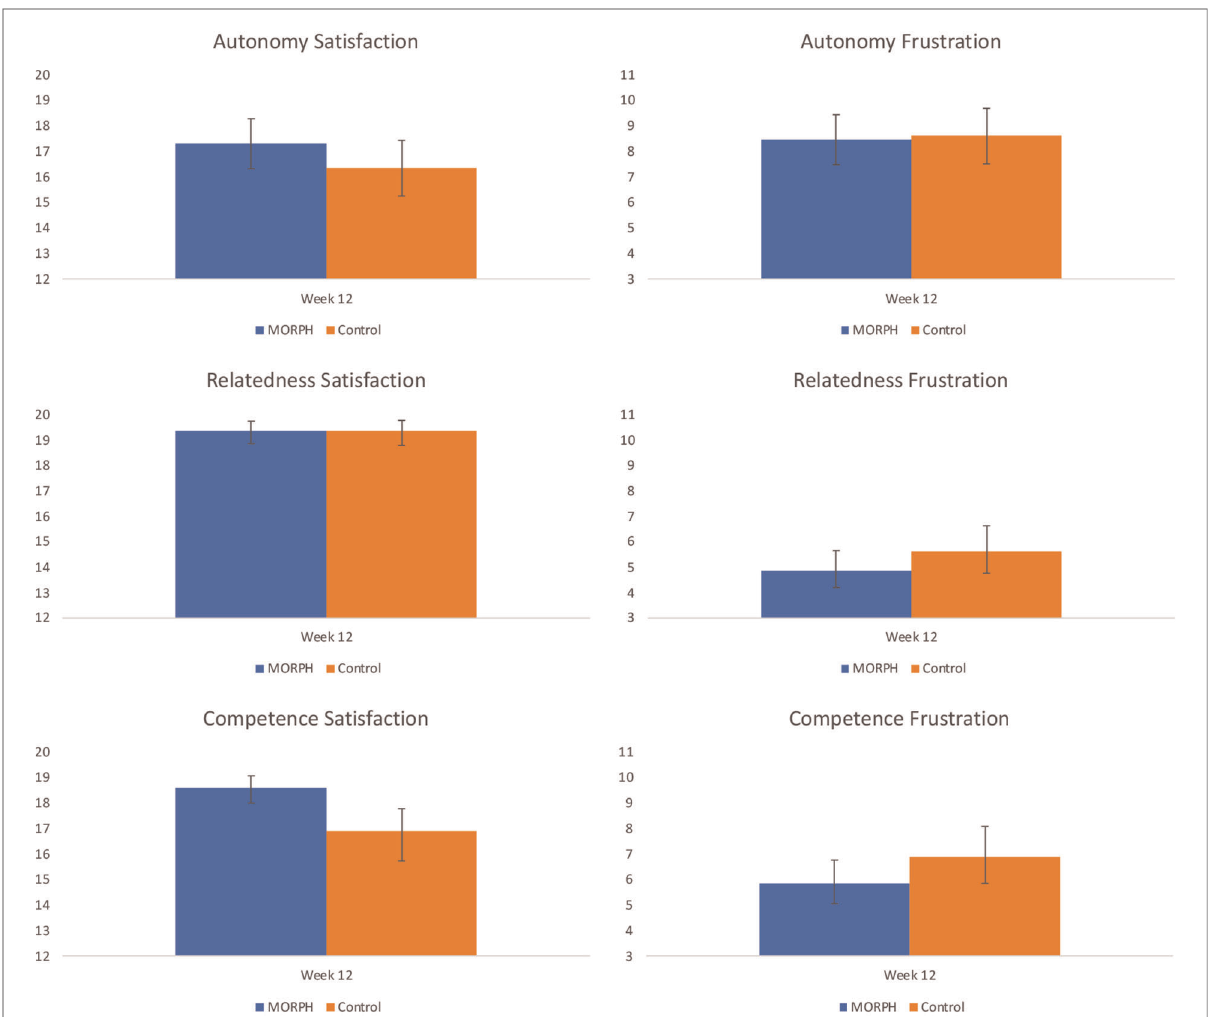
FIGURE 7 Baseline-adjusted basic psychological needs satisfaction and frustration scores at week 12. Note, relatedness and competence scores were natural log transformed (re fl ected for satisfaction scores) to account for skewed residuals. Back-transformed values are presented